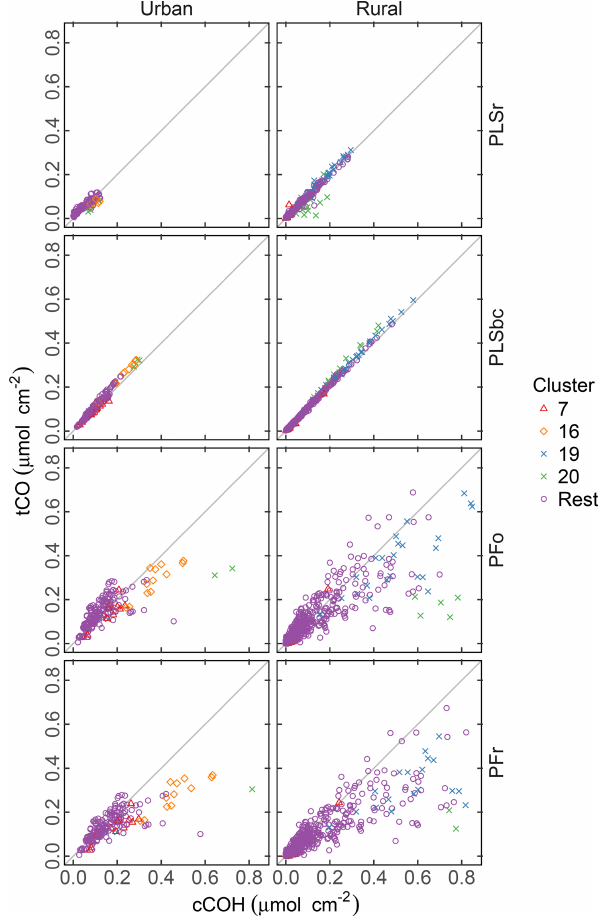
Figure 8. Comparison of quantified abundance of tCO and cCOH. PFo refers to peak fitting using the original parameters. PLSr refers to partial least square using raw spectra. PFr refers to peak fitting using the recalibrated absorption coefficients. PLSbc refers to par- tial least square using baseline-corrected